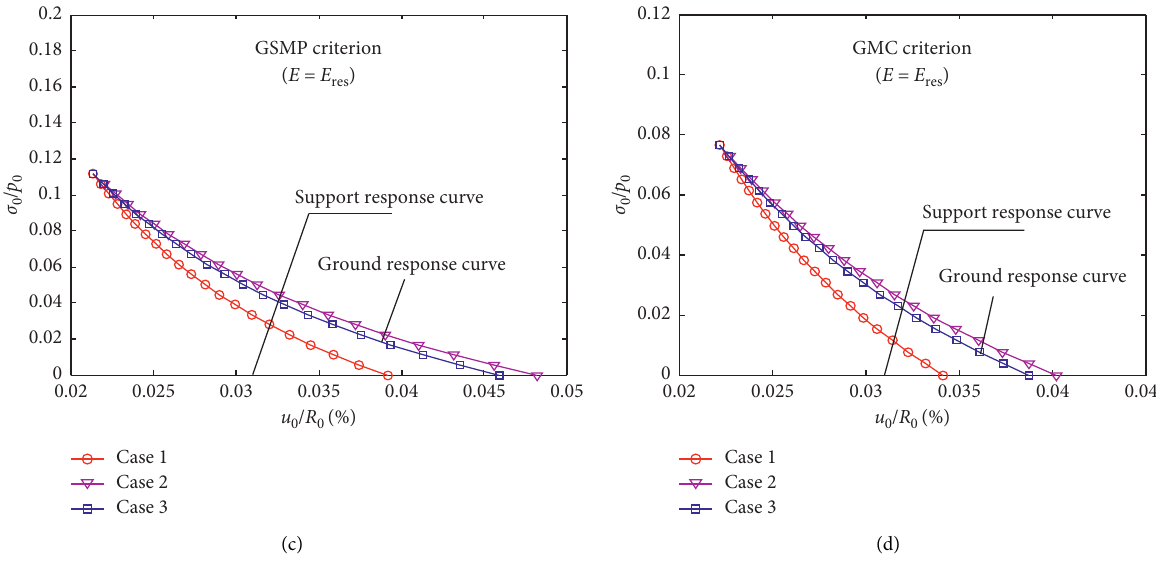
Figure 12: The effect of elastic strain form on the ground response curve (note: Young’s modulus attenuation is ignored in Case 3).